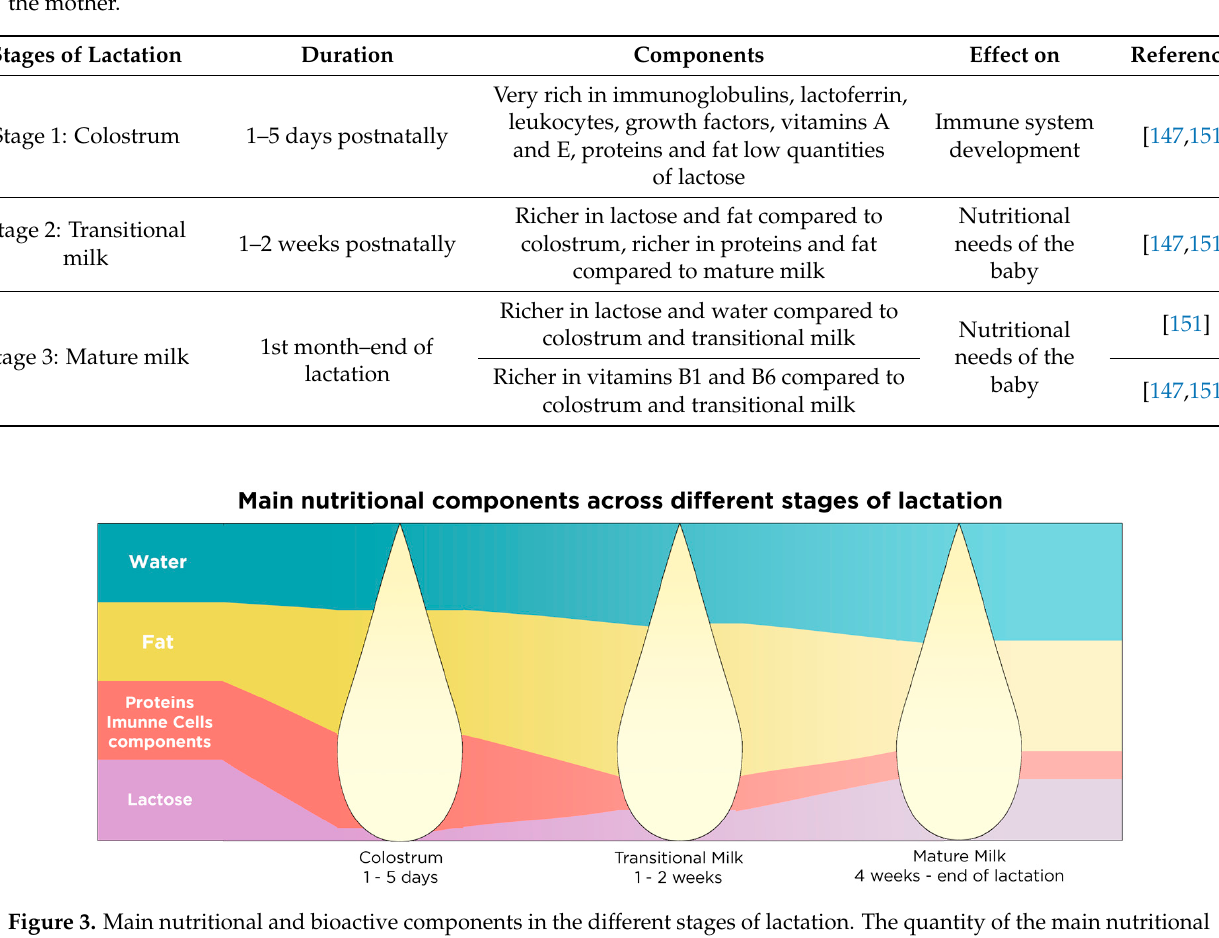
Table 1. Main components of human milk on the three stages of lactation and the effect on infant health. The cessation of breastfeeding is specific to each mother-infant dyad; it is decided according to the needs of the infant and upon the choice of the mother.